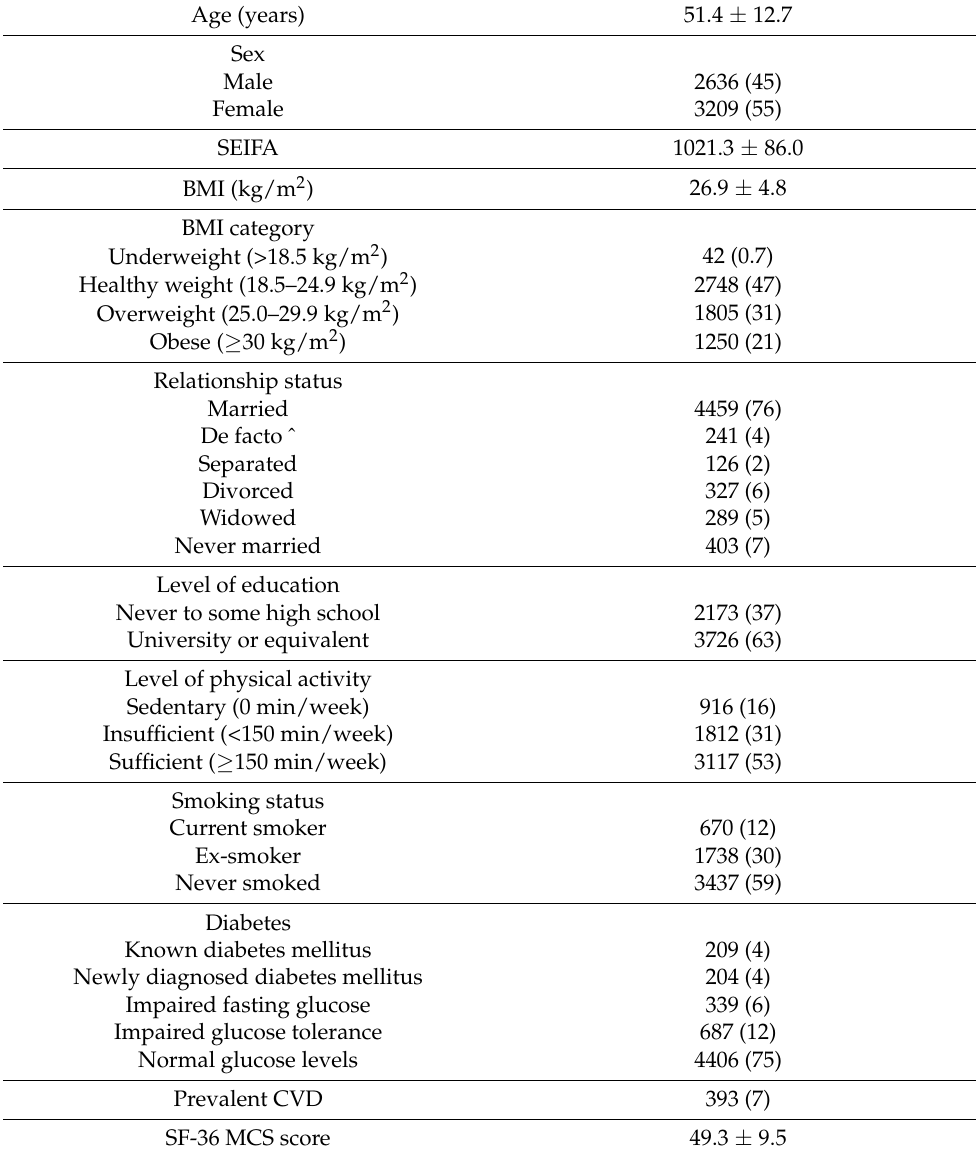
Table 1. Baseline characteristics of covariables and dietary intakes of 5845 Australian adults from the AusDiab